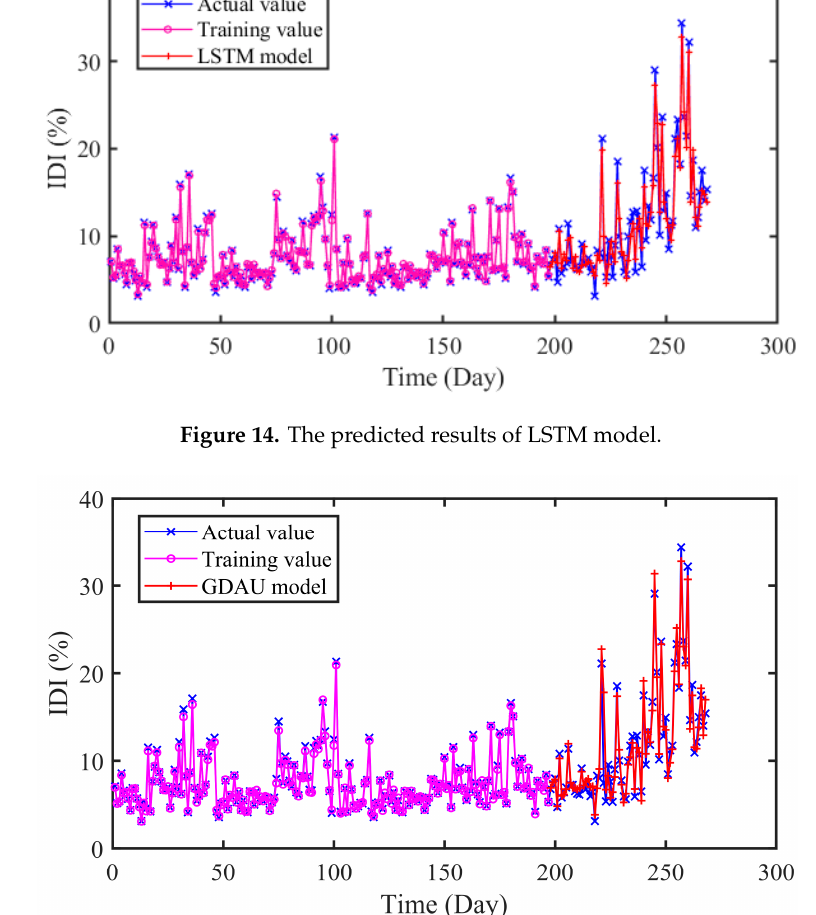
Figure 15. The predicted results of GDAU model .